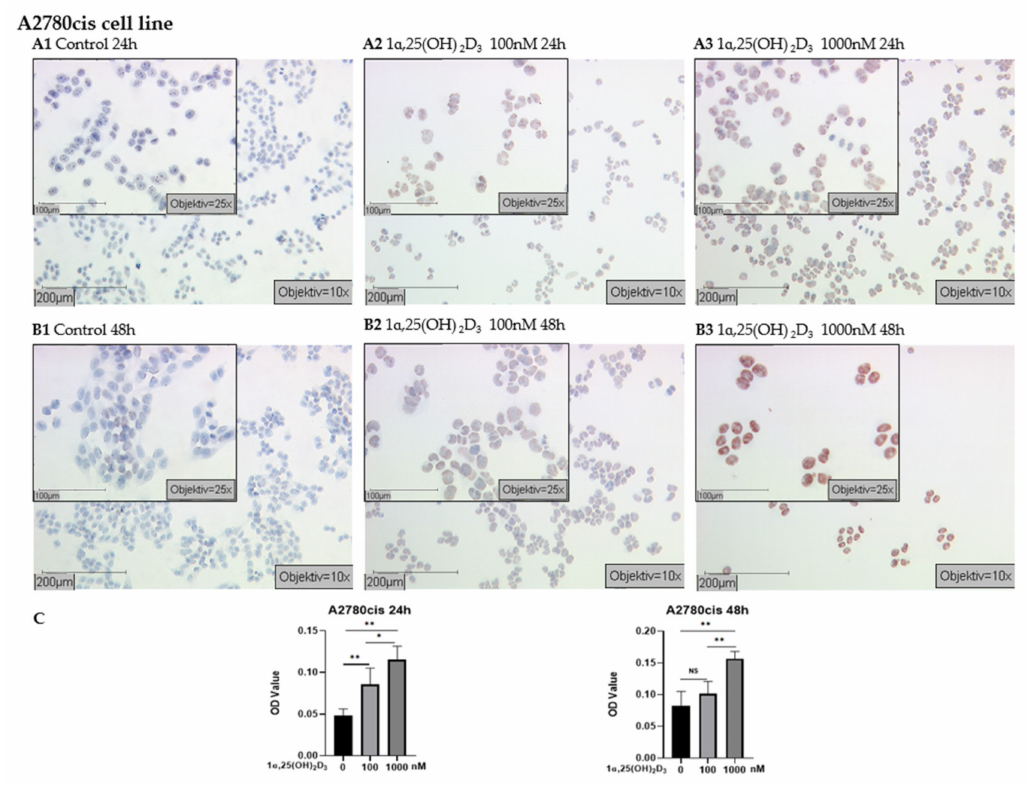
Figure 5. Detection of H3K4me3 with immunocytochemistry in A2780cis cell line: ( A ) representative pictures of H3K4me3 immunocytochemistry staining of A2780cis cells treated with 1 α ,25(OH) 2 D 3 at di ff erent concentrations for 24 h (A1 control; A2 100 nM 1 α ,25(OH) 2 D 3 ; A3 1000 nM 1 α ,25(OH) 2 D 3 ); ( B ) representative pictures of H3K4me3 immunocytochemistry staining of A2780cis cells treated with 1 α ,25(OH) 2 D 3 at di ff erent concentrations for 48 h (B1 control; B2 100 nM 1 α ,25(OH) 2 D 3 ; B3 1000 nM 1 α ,25(OH) 2 D 3 ) (scale bars 200 µ m, small pictures 100 µ m); ( C ) ImageJ-based quantification of immunocytochemistry staining of H3K4me3 in A2780cis cell line; NS, no statistical significance ( p > 0.05); * with statistical significance ( p < 0.05); ** with high statistical significance ( p <